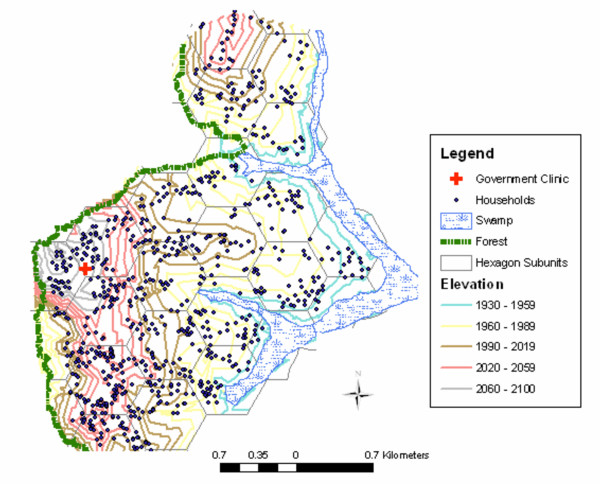
Geography and household locations in Kipsamoite, Kenya.